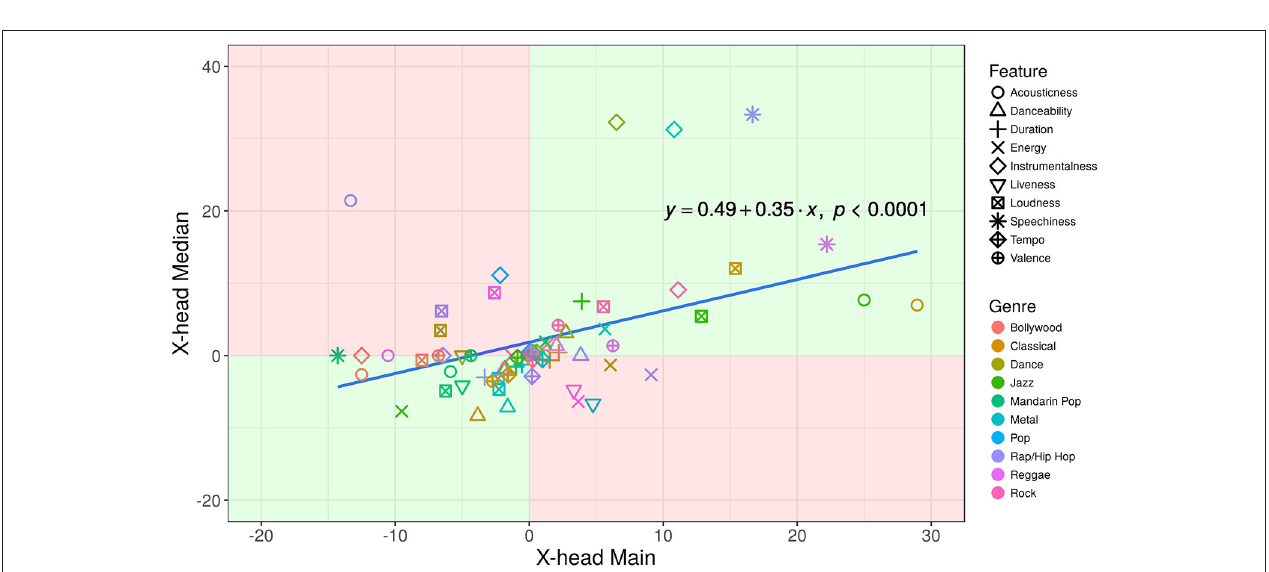
FIGURE 7 | Scatterplot showing the 100 diagonal-to-median cell pairings of the 10 feature-influence matrices. Light-green quadrants indicate sign agreement between the row medians and X-heads with respect to their main genres, either positive or negative; pink quadrants indicate sign disagreement.